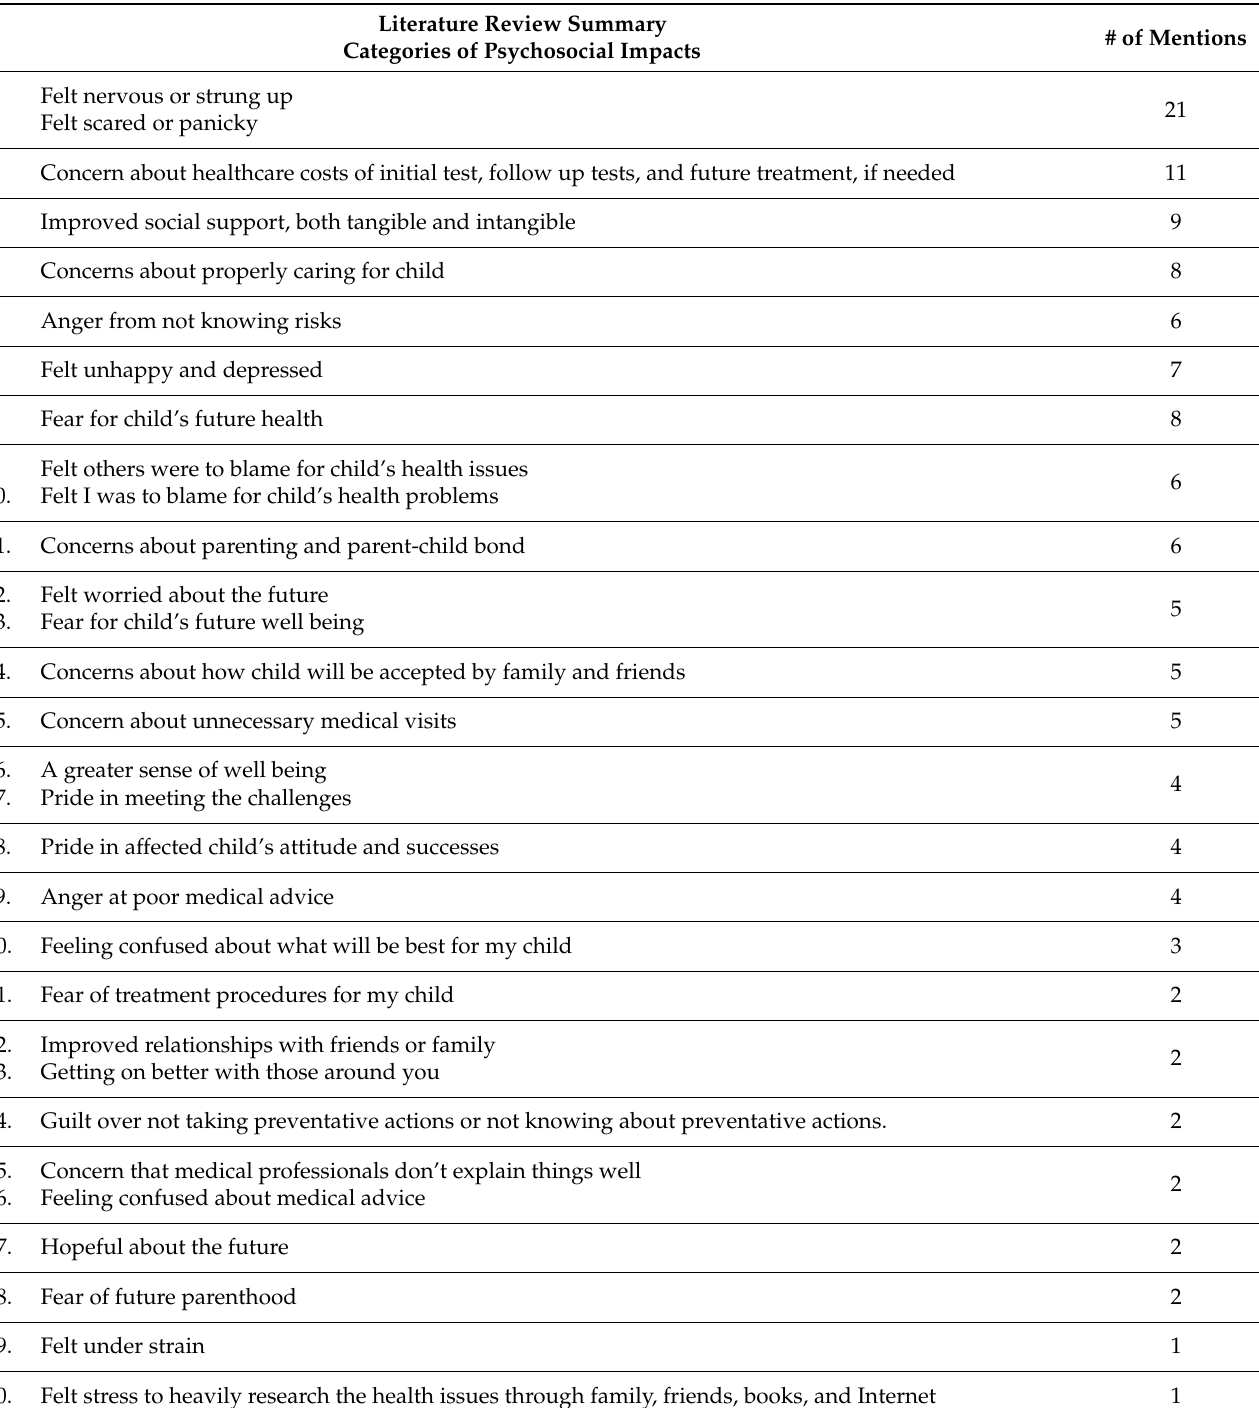
Table A1. Categories of Psychosocial Impacts Identified in Literature